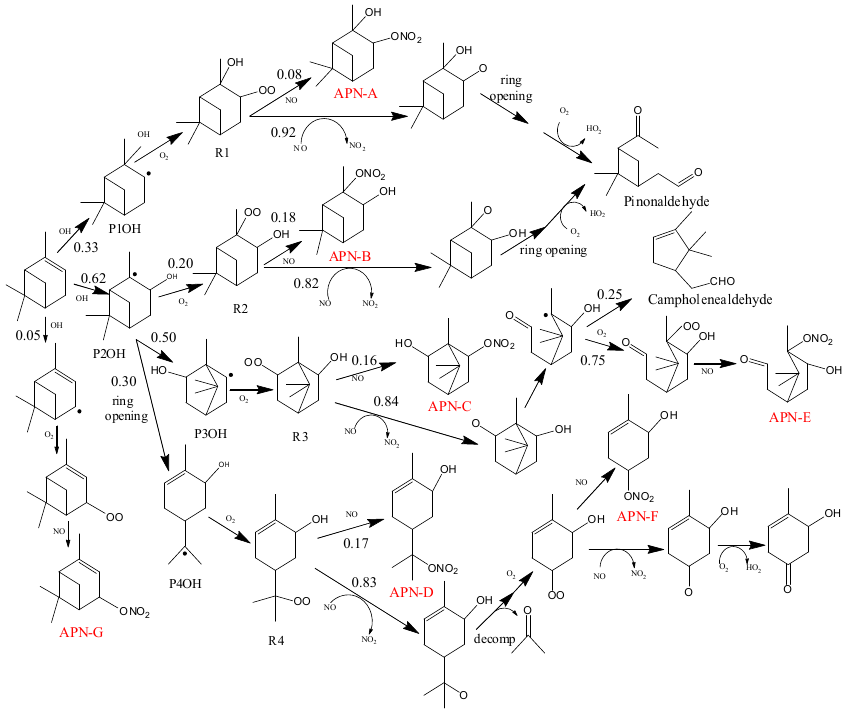
Fig. 4. Schematic of the mechanism for the OH-initiated degradation of α -pinene to first generation products in the presence of NO.